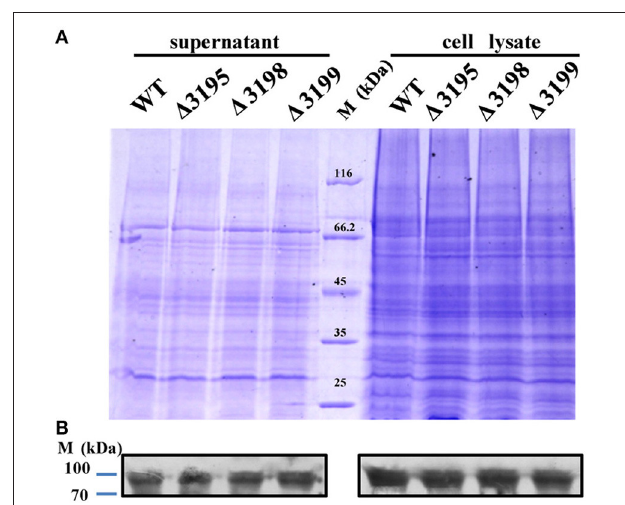
FIGURE 4 | SDS-PAGE analyses of the extracellular supernatant and cell lysate from WT and t2s mutant strains (A) and western blot detection for the extracellular or intracellular CHU_0344 protein using the antibody against CHU_0344 (B) . Loading samples were normalized by calibration of cell biomass or total proteins. Proteins were stained with Coomassie brilliant blue. The signals of CHU_0344 with almost the same intensity from different cell lysates verified an equal protein loading between